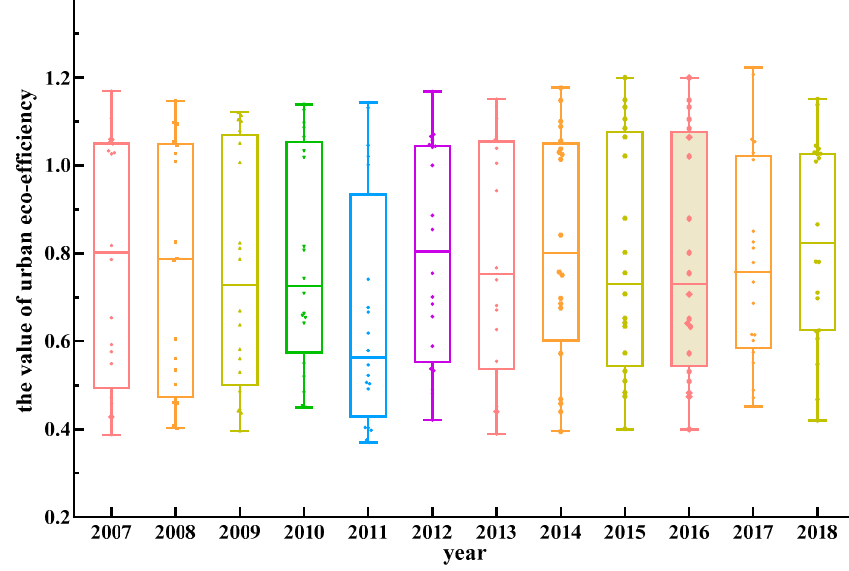
ffi ciency in the lower reaches of the Yellow Figure 3. Boxplot of the urban eco-efficiency in the lower reaches of the Yellow River. Figure 3. Boxplot of the urban eco-e